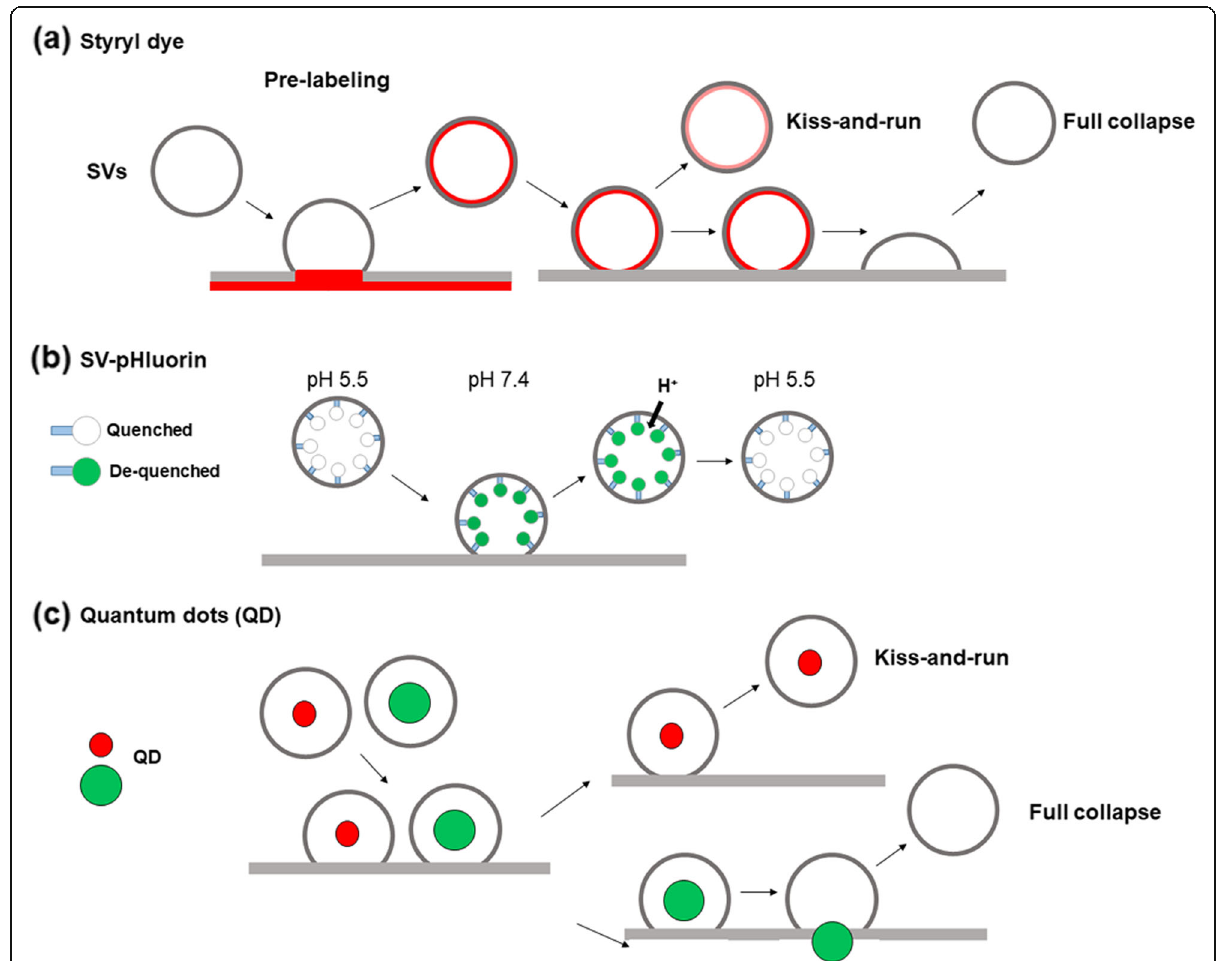
Fig. 1 Optical measurement of presynaptic activity with fluorescent probes. Measurement of presynaptic activity with styryl dye ( a ), SV-pHluorin ( b ), and quantum dots ( c